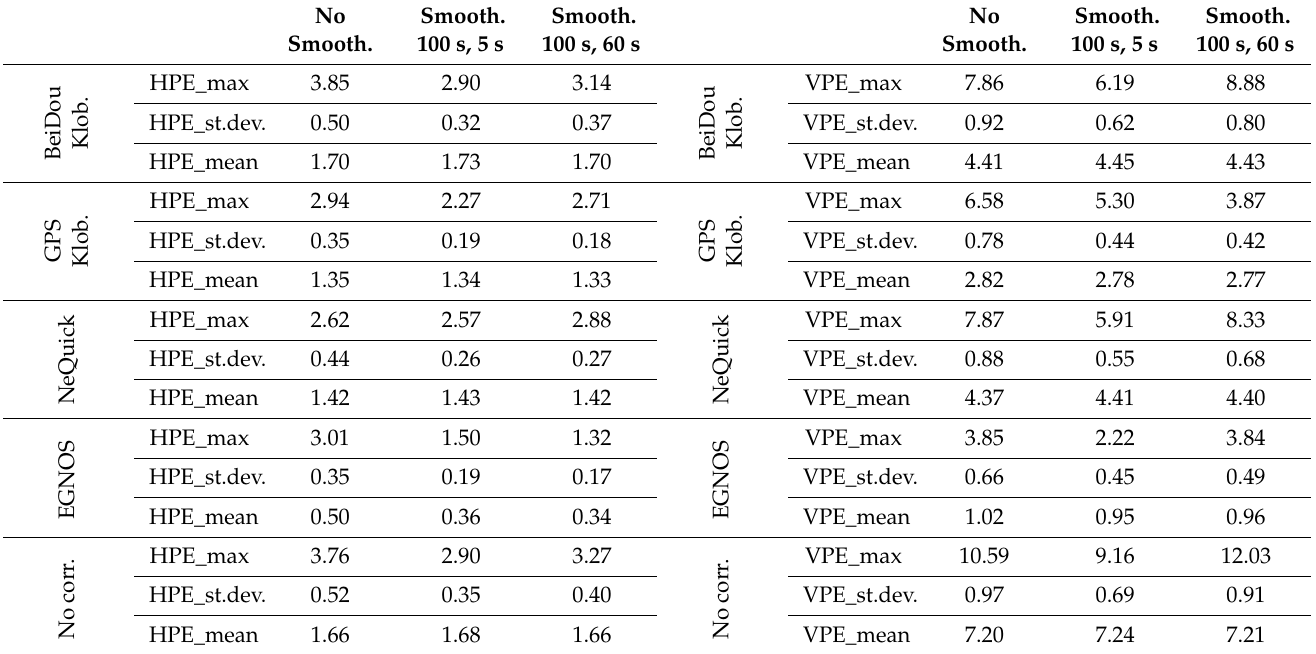
Table 1. Numerical results of accuracy analysis related to horizontal and vertical positioning errors. No Smooth. Smooth. Smooth.